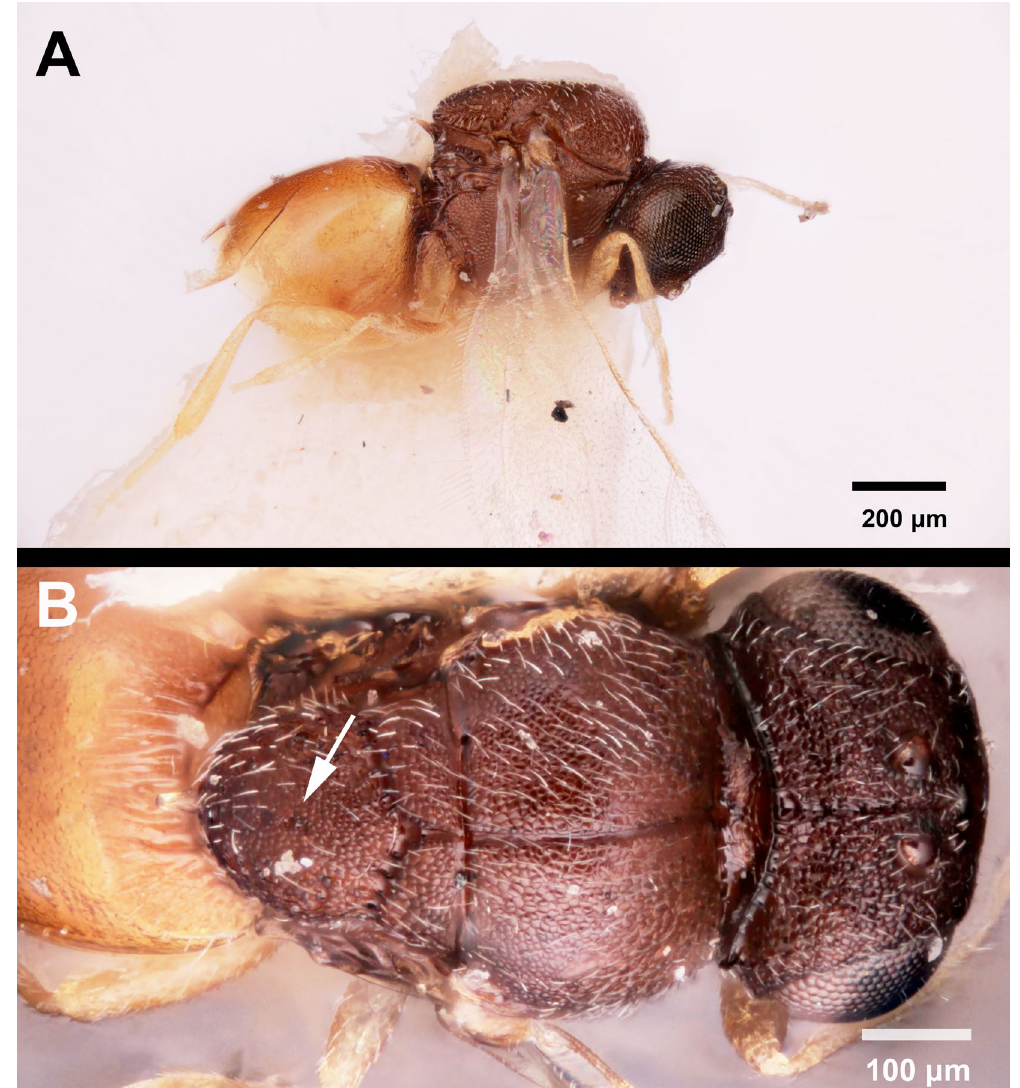
Fig. 2. Ceraphron mymecophilus kieffer, 1913, synonymized with Aphanogmus abdominalis (Thomson, 1858). Syntype, ♂ (MNHN EY22475). A . Lateral view. B . Dorsal view, with arrow pointing to the fovea on the mesoscutellum characteristic of Aphanogmus abdominalis (Thomson,